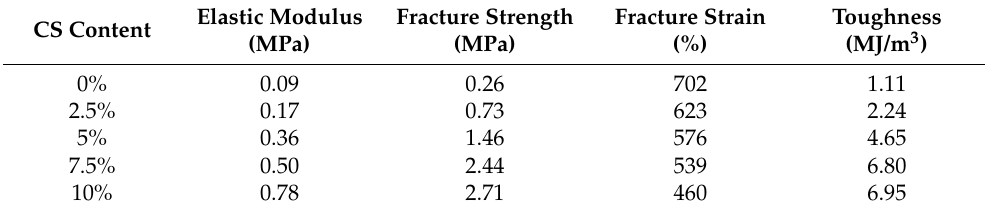
Table 1. The detailed mechanical properties of the DN hydrogels with different CS contents.